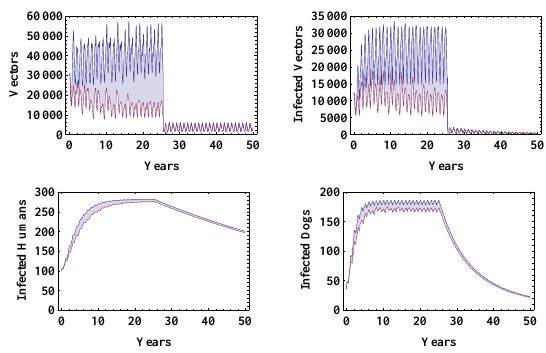
Fig. 8. Case (vii): Model behavior with variability in τ 2 .